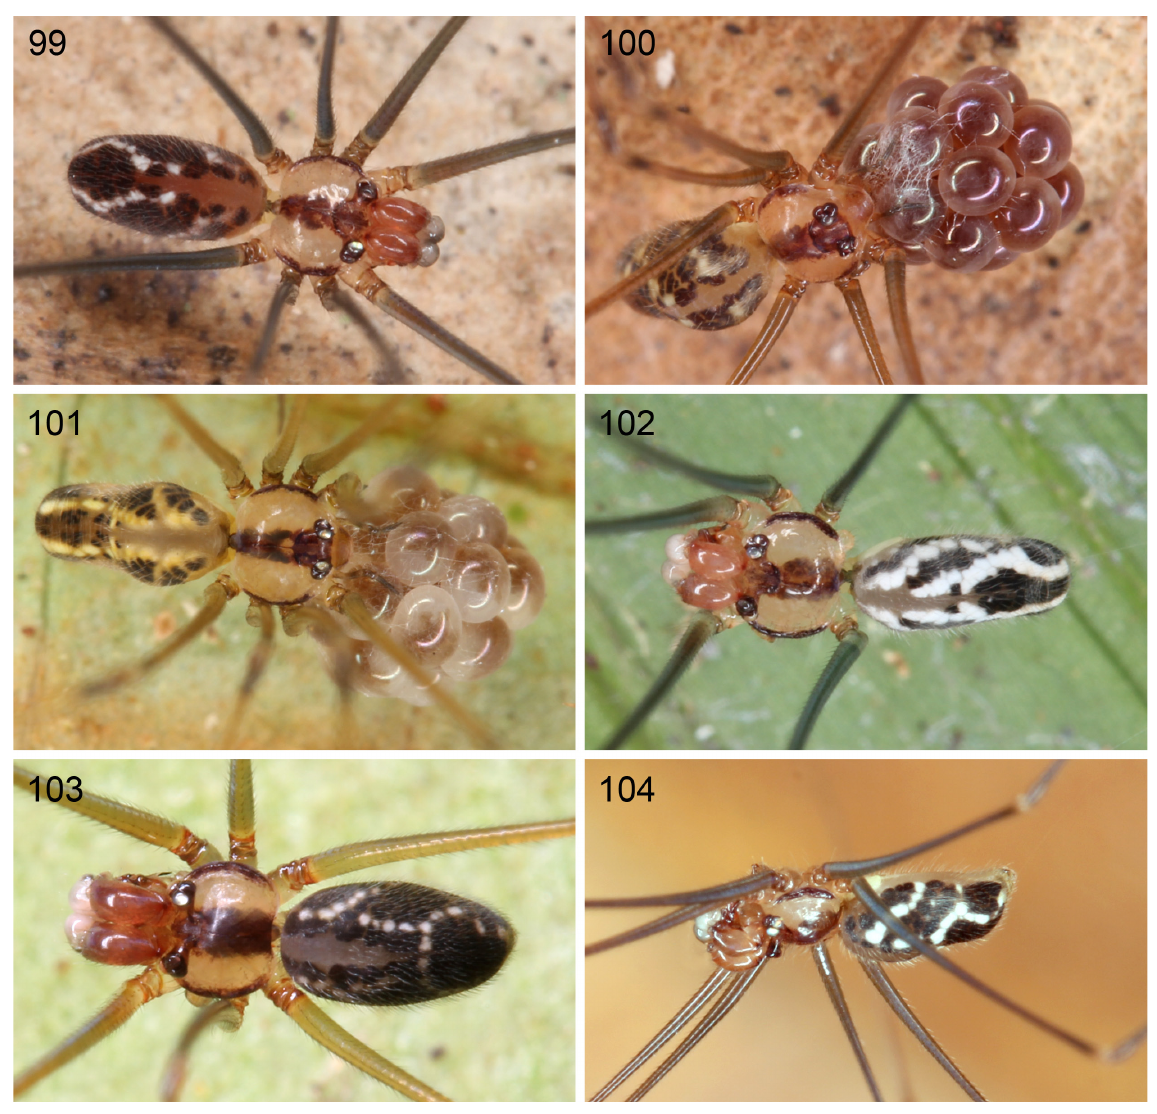
Figs 99–104. Live specimens. Aetana kinabalu group. — 99–103 . A. kinabalu Huber, 2005. ♂ and ♀ with eggsac from Gunung Mulu, Sarawak (99, 100); ♀ with eggsac and ♂ from Crocker Range, Sabah (101, 102); and ♂ from Mt. Kinabalu, Sabah (103). — 104 . A. gaya Huber, sp. nov., ♂ from Gaya Island,